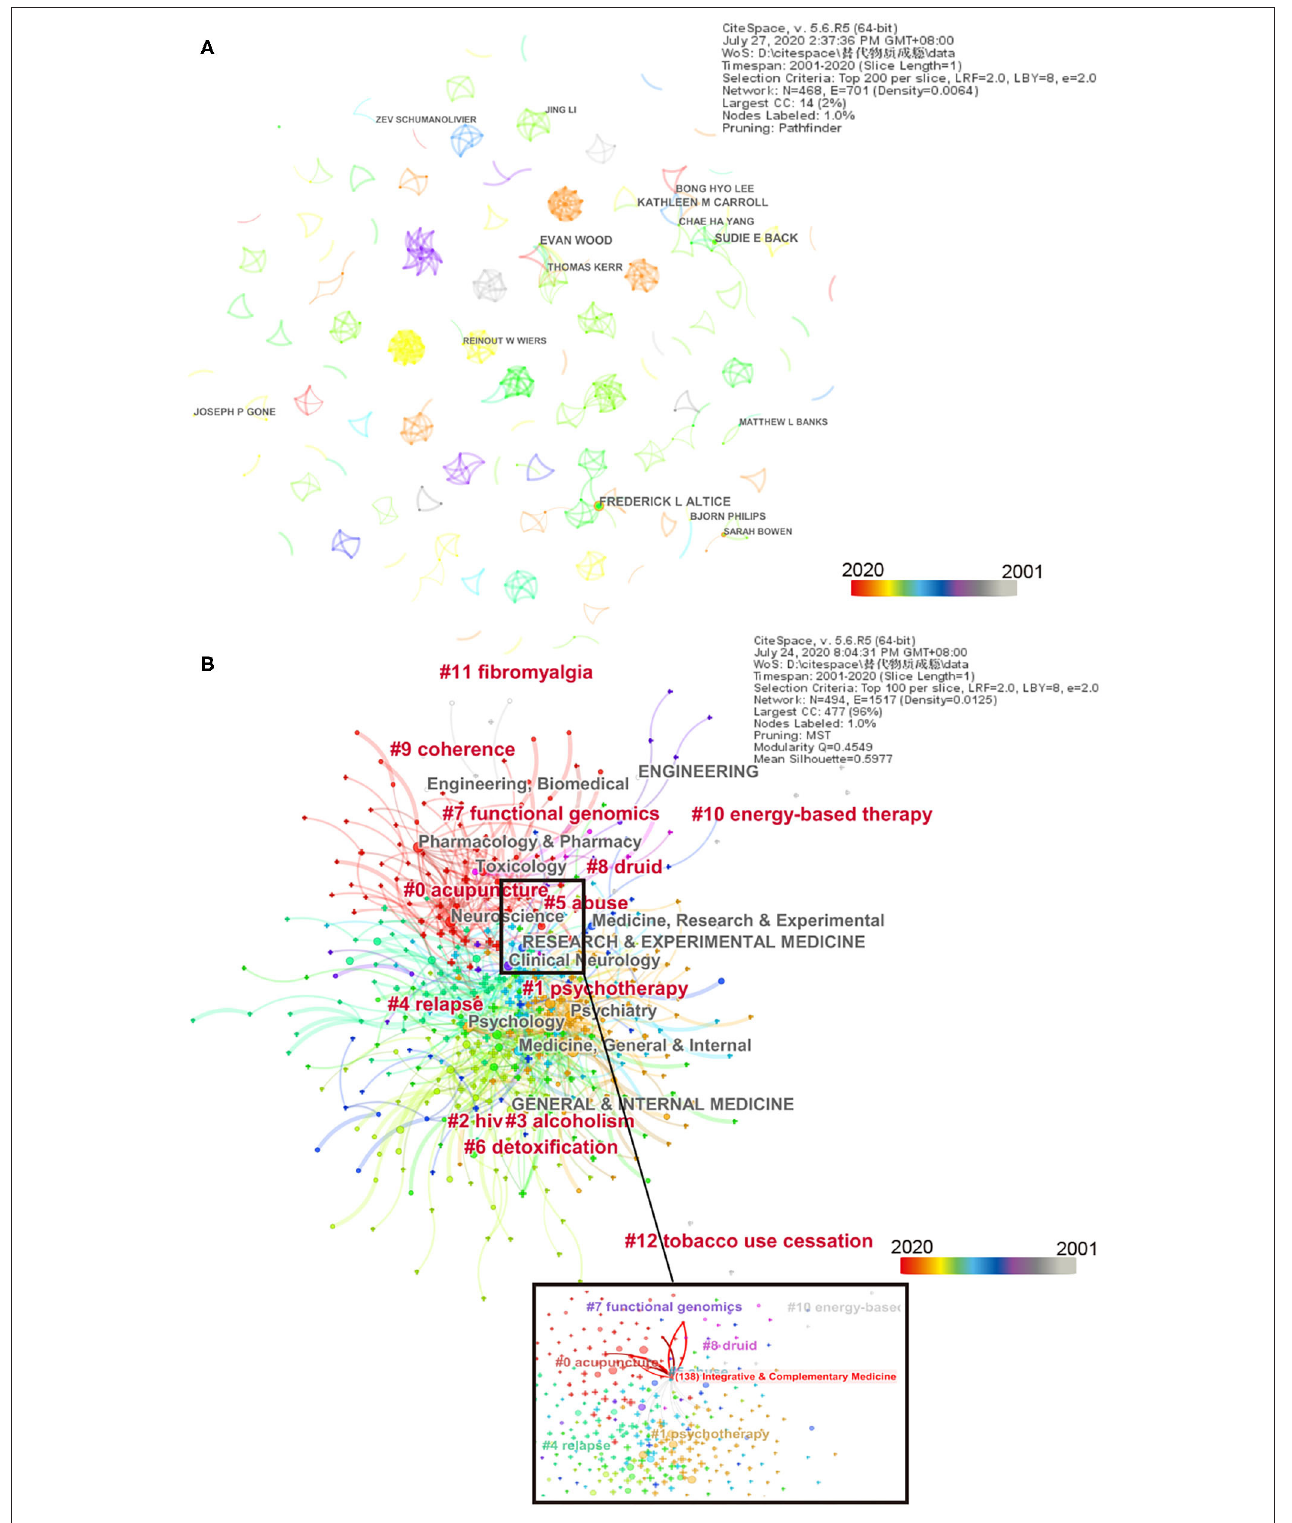
FIGURE 4 | Network map of complementary and alternative medicine (CAM) for substance use disorders (SUDs) by author and category. (A) Regarding the network map by authors, top 14 results present CAM for SUDs. A total of 468 authors participated, including 468 nodes and 701 links. (B) The co-occurrence network map of the cluster by category (top 10 result); 494 nodes and 1,517 links were included. The modularity Q is 0.4549, and the mean silhouette is 0.5977. Time slice on 1 year, and different colors present different years as the legend shows. The color lines between authors indicate their first cooperation time, and the thickness of the lines indicates the times of authors’ cooperation. The area in similar color suggests similar clusters and shows cluster at the corresponding time as well.